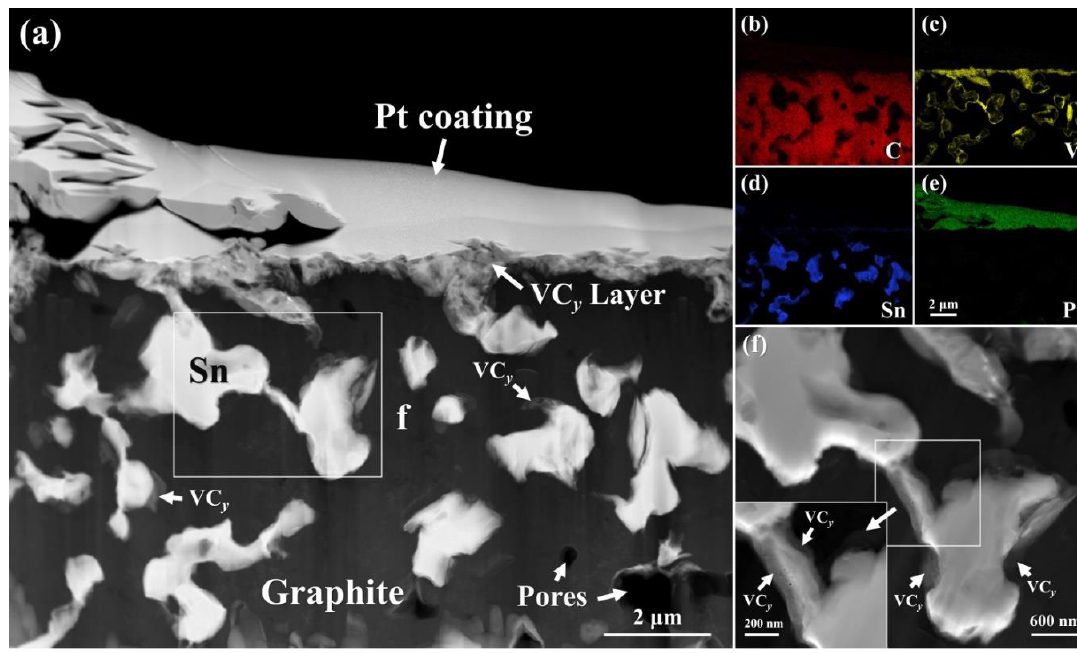
Figure 7. ( a ) cross-sectional HAADF TEM image obtained at the three-phase contact line between Sn-3V alloy and porous graphite after isothermal wetting at 850 °C and corresponding elemental distribution of ( b ) C, ( c ) Sn, ( d ) V, and ( e ) Pt; ( f ) was acquired at the location marked as rectangle f in ( a ). Note that the partial Sn at the three-phase contact line was removed and Pt was introduced as a protective coating.